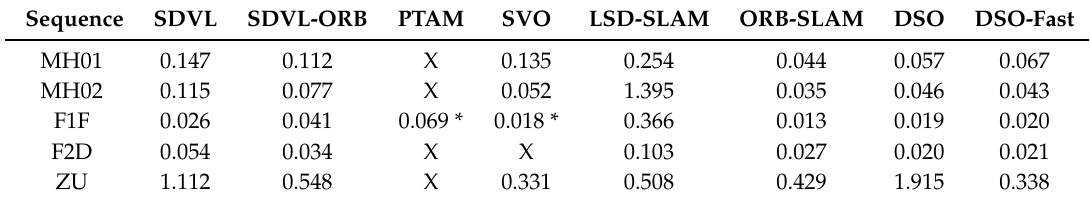
Table 3. Accuracy comparative (in meters).